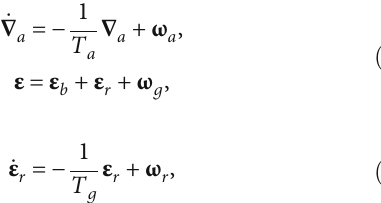
Figure 4: The skyplot of the visible